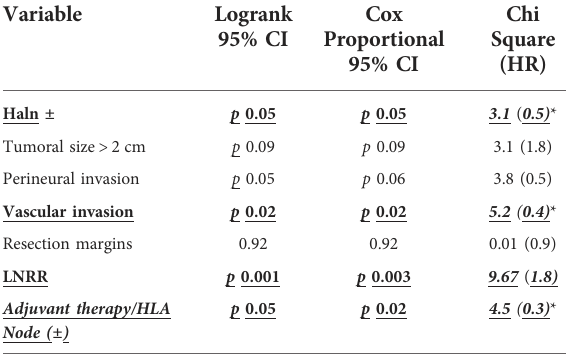
TABLE 3 Log rank and Cox regression analysis for